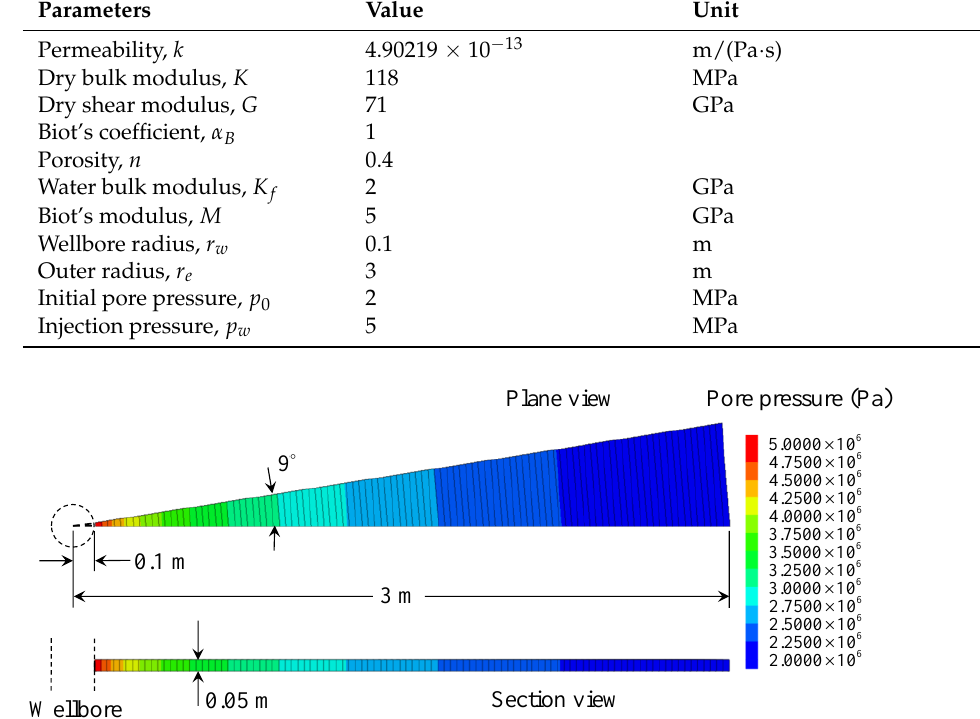
Figure 3. Pore pressure contours of the numerical calculation (FLAC3D).